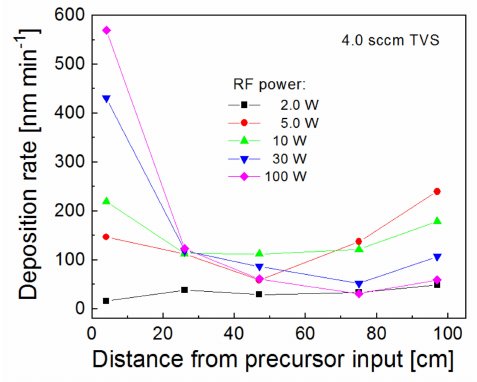
Figure 2. Deposition rate along the tubular reactor for plasma nanocoatings deposited at a TVS flow rate of 4.0 sccm and di ff erent RF powers.